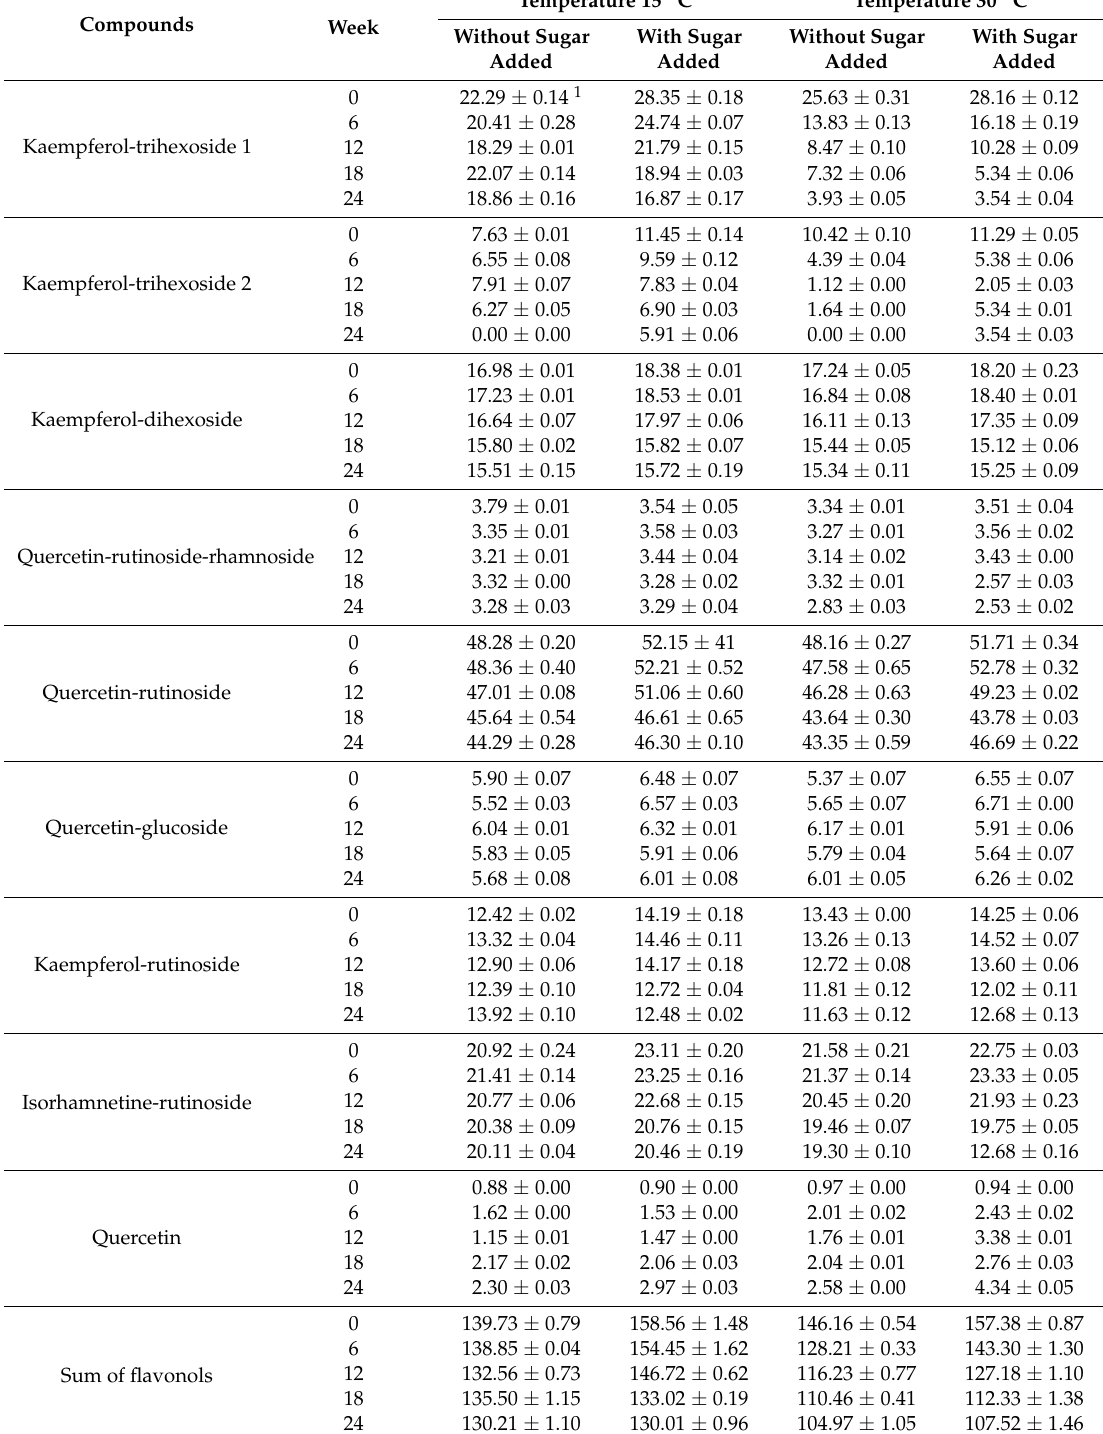
Table 3. Changes in flavonols content ( µ g/mL) during cherry liqueurs